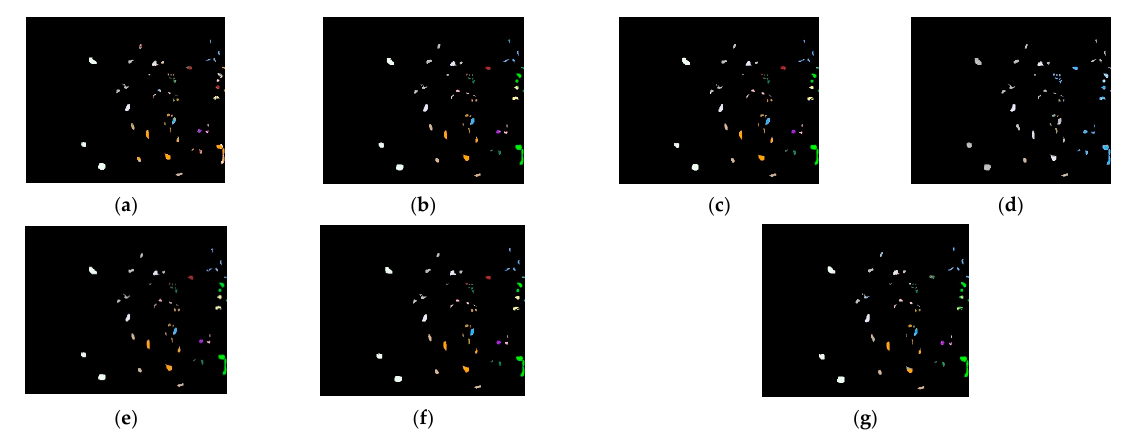
feature; ( b ) KNN—fusion feature; ( c ) LR—fusion feature; ( d ) NBM—fusion feature; ( e ) SVM—fusion feature; ( f ) SVM—